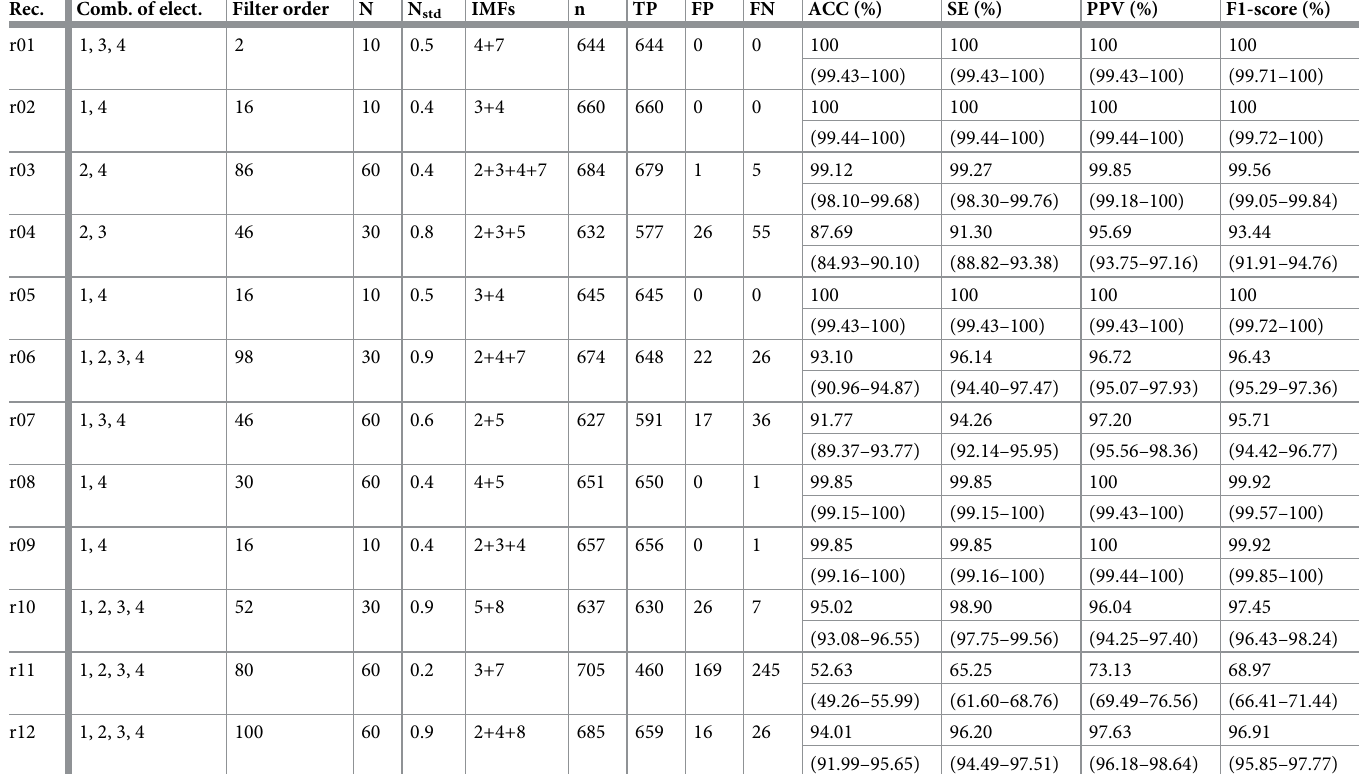
Table 1. Statistical evaluation of the fQRS complexes detection obtained by using the ICA-RLS-EEMD method and the FECGDARHA database (the 95% confidence interval is reported in parenthesis). Rec. Comb. of